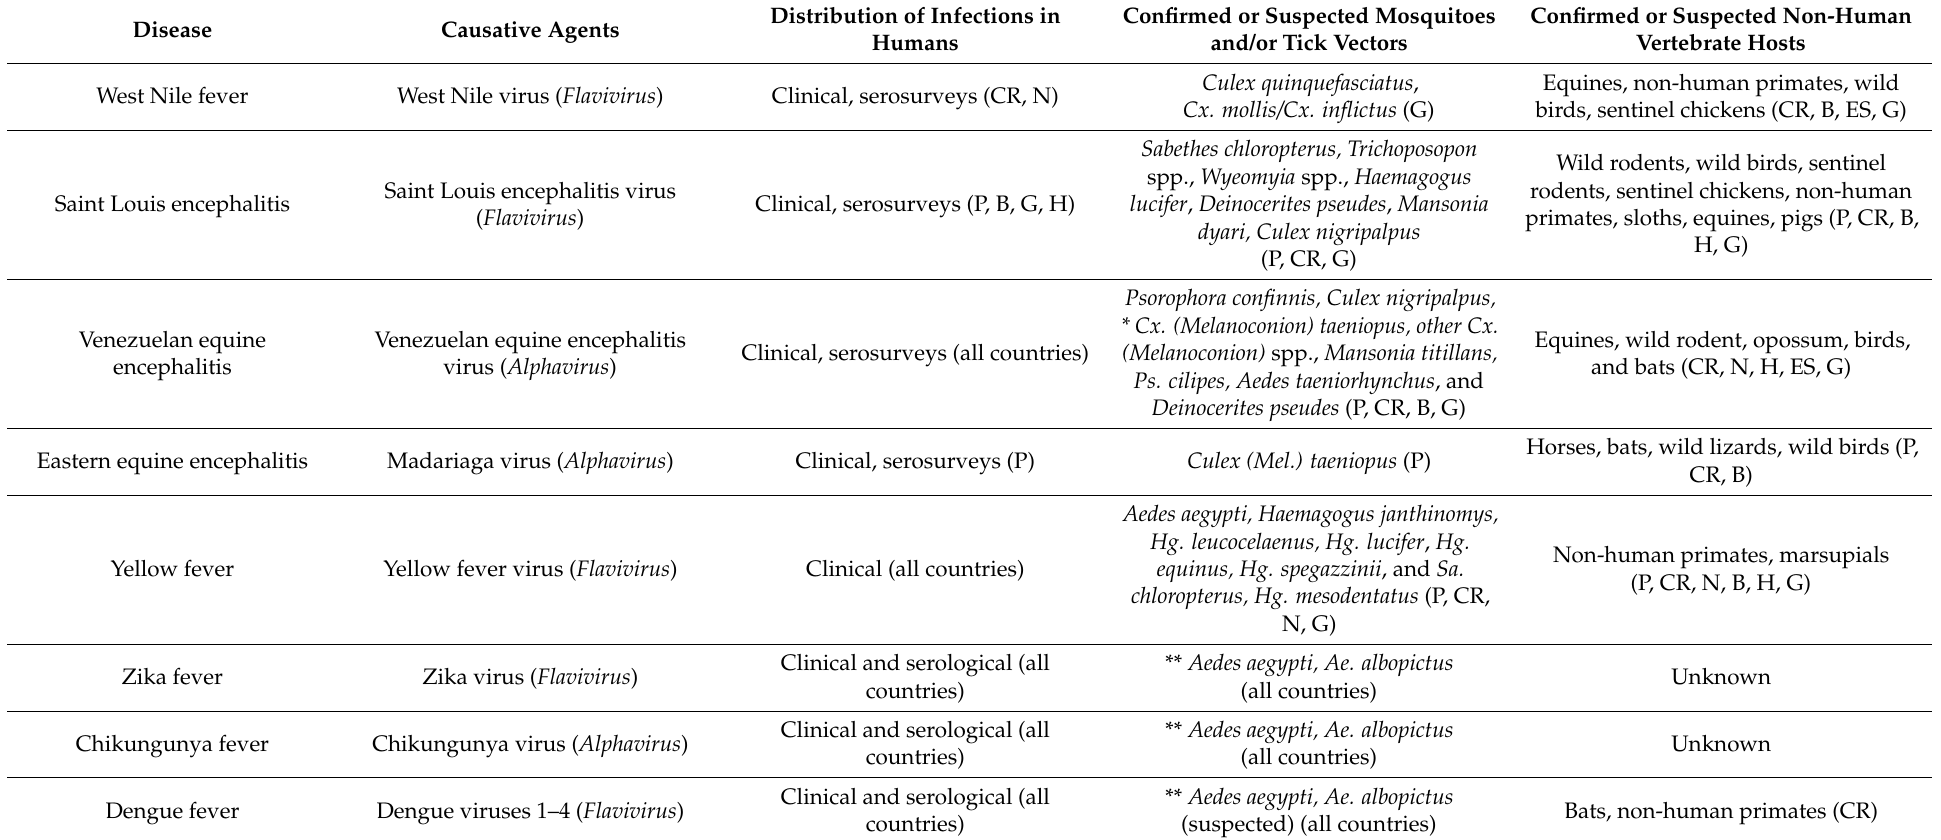
Table 2. Description of the most important mosquito-borne and tick-borne diseases in Central